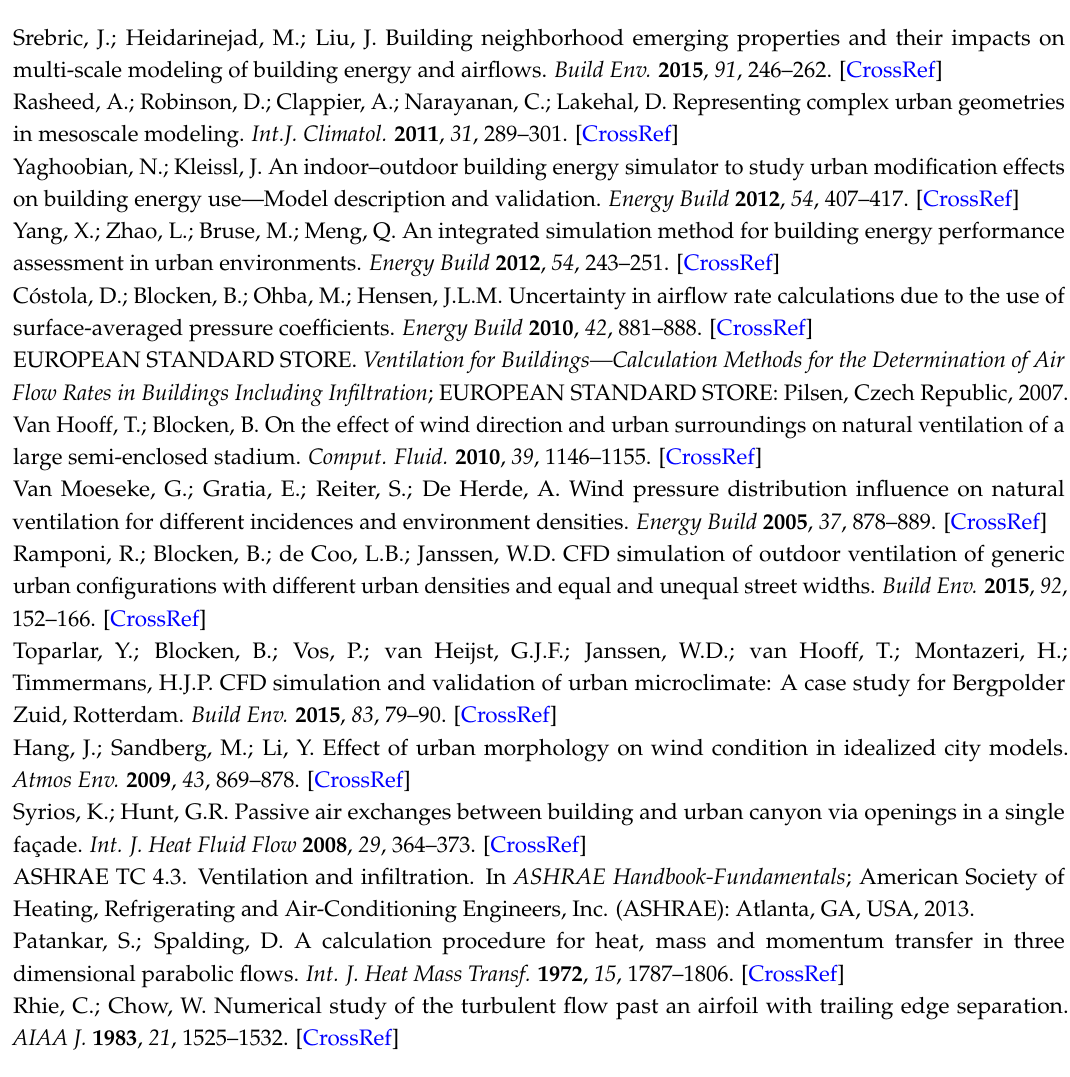
Figure A1. Air pressure distribution and wind pressure coefficient distribution on the surfaces of one building (UM-2 case, perpendicular wind), used as an example. Table A1. Steps and results of air change rate and heat losses calculations for the example building.